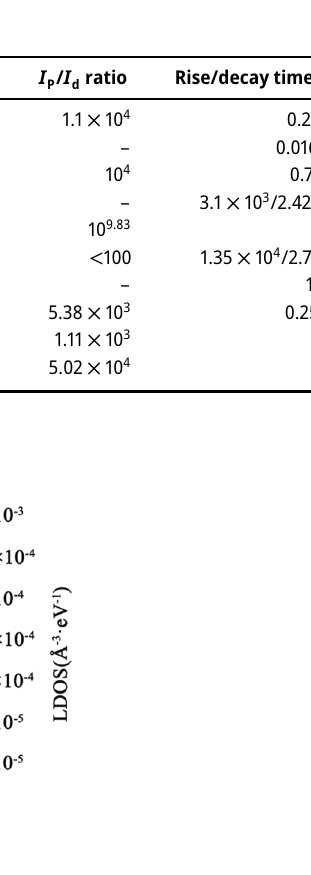
MW photodetector. (a) Photocurrent versus time plot of CdSe NB/CsPbBr 3